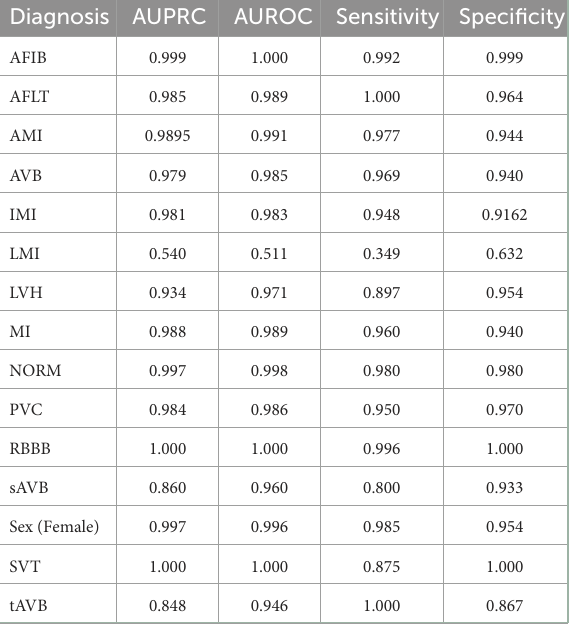
TABLE 1 Test results of models trained on PTB-XL ECGs and tested on a holdout test set from